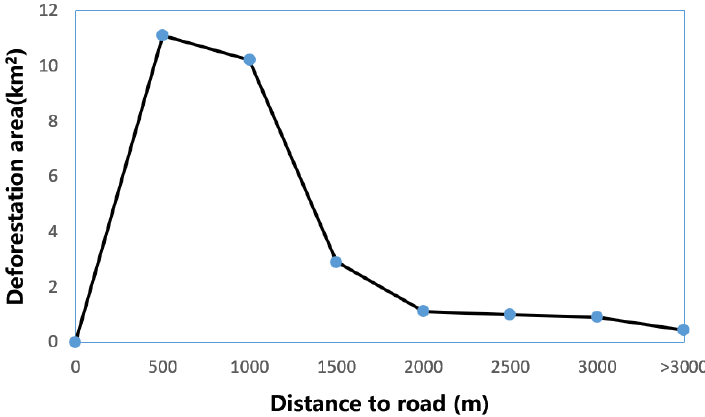
Figure 9. The statistics result for deforestation.